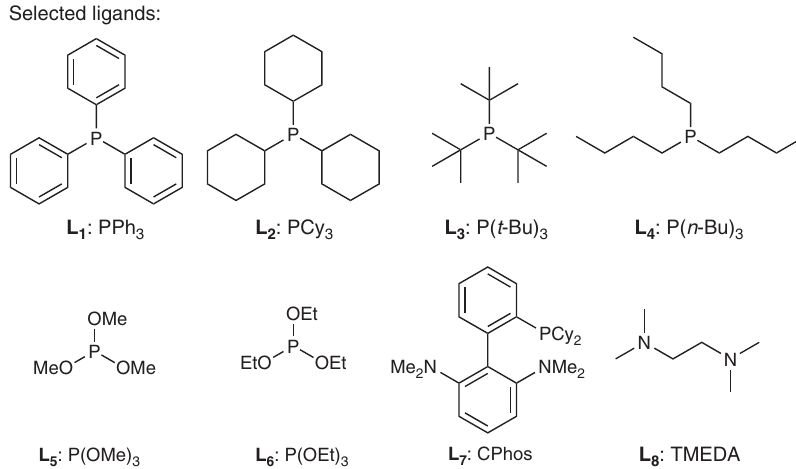
Figure 3 | Selected ligands. Monodentate and bidentate ligands were screened, also see Supplementary